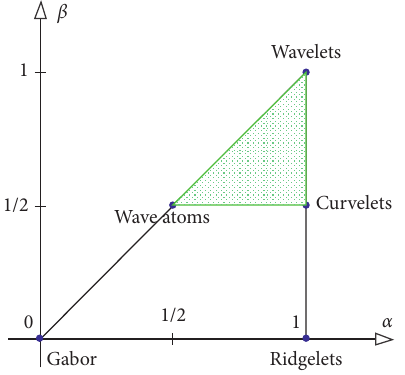
Figure 1: Various transforms ( α , β ) as wave packet families